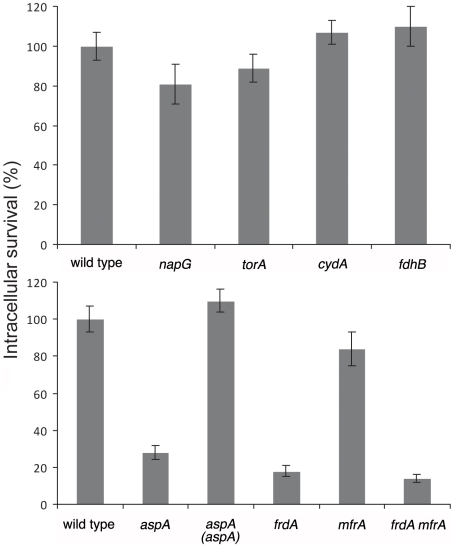
Intracellular survival of C. jejuni mutant strains defective in specific respiration pathways.Cultured mammalian cells were infected with the wild type C. jejuni 81–176 strain (WT) and the indicated mutant derivatives at a MOI of 100 for 2 hs, followed by 2 and 18 hs incubation in the presence of gentamicin. For each strain, levels of intracellular bacteria at 20 hs after infection are shown relative to the levels obtained at 2 hs after infection. The value of the ratio in wild type was set at 100%. The error bars represent the standard deviation of three independent determinations. The survival values at 20 hs of the aspA, frdA, or frdA mfrA double mutant strains were statistically significantly different (P<0.05, Student t test) from those of wild type.